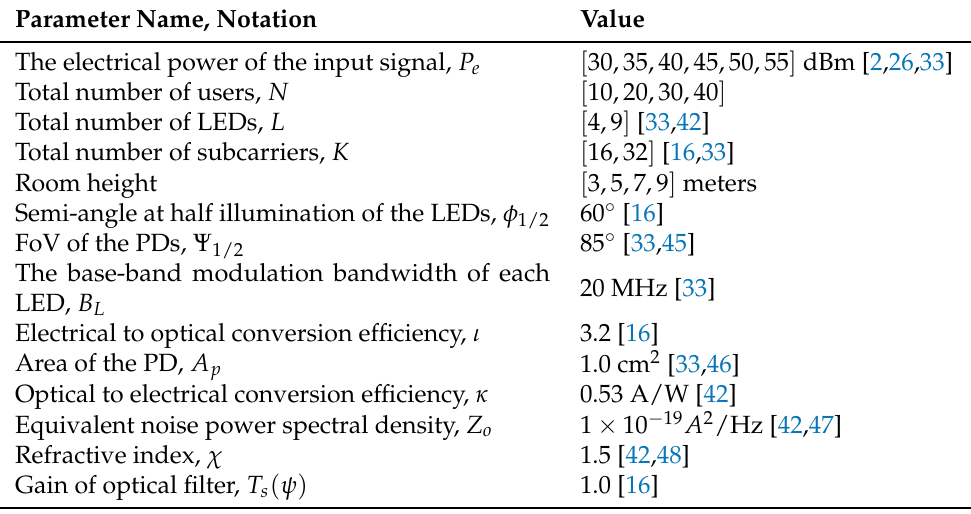
Table 2. Network